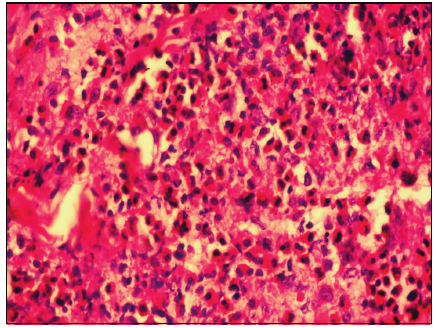
Figure 3: Eosinophilic infiltrates of skin